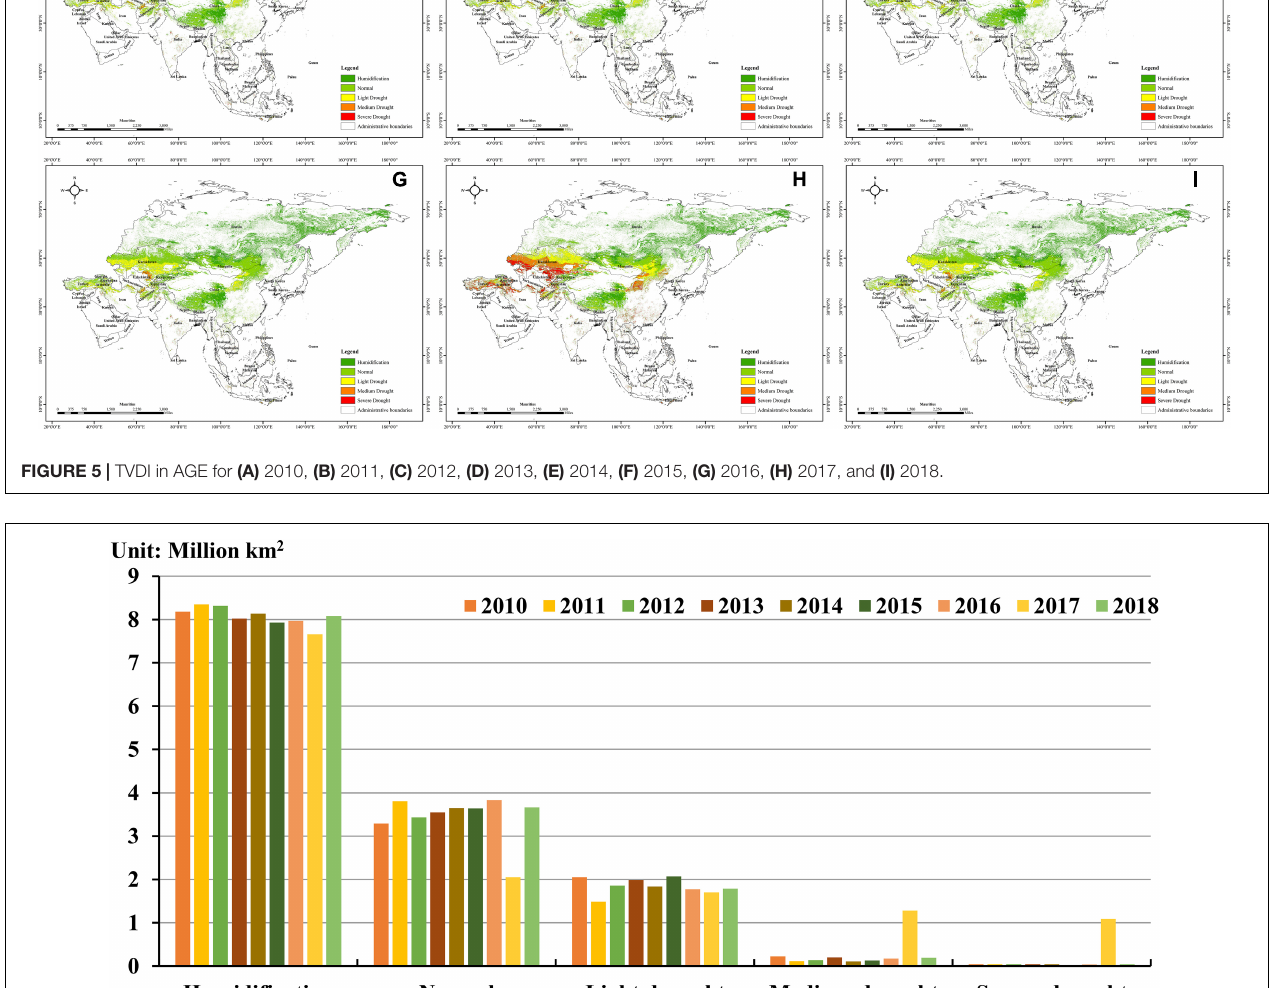
trend in humid areas of AGE from 2010 to 2018. The area of the normal area increased from year to year. The area of light drought areas increased from 2010 to 2015 but decreased from 2015 to